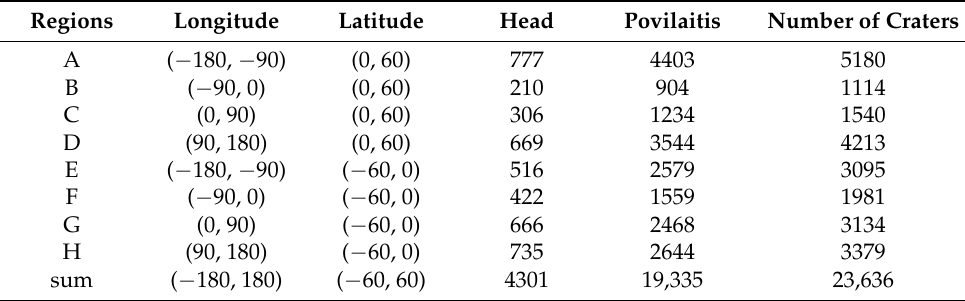
Table 1. Lunar crater distribution of eight